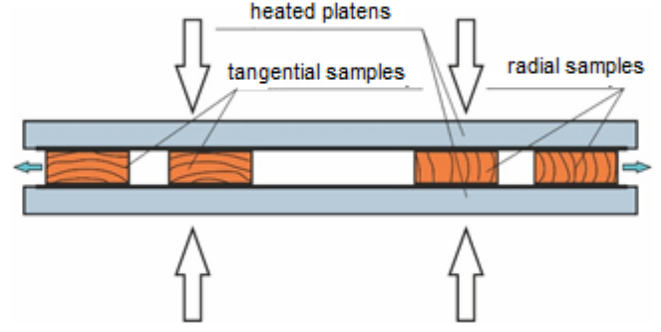
Figure 1. Scheme of sample storage during contact drying.